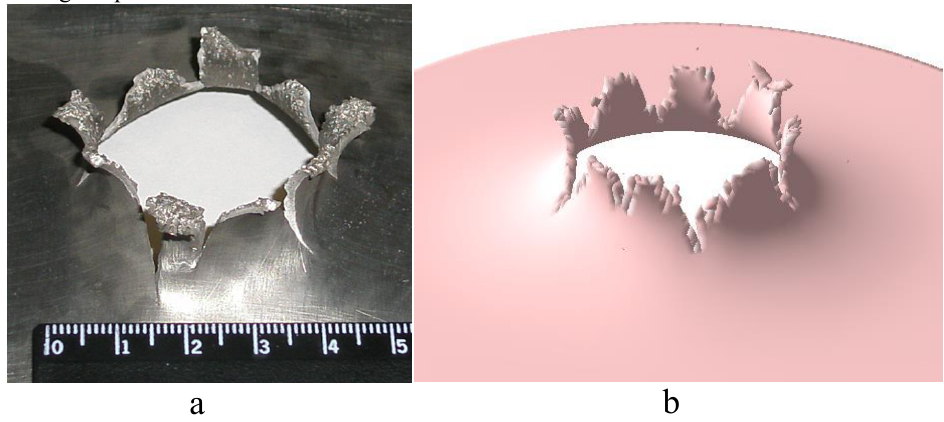
a b Fig. 3. Penetration of a plate 1.7 mm thick from the AMg6 alloy by an aluminium spherical striker with a diameter of 9 mm, an impact velocity of about 800 m/s; a) experiment; b) numerical